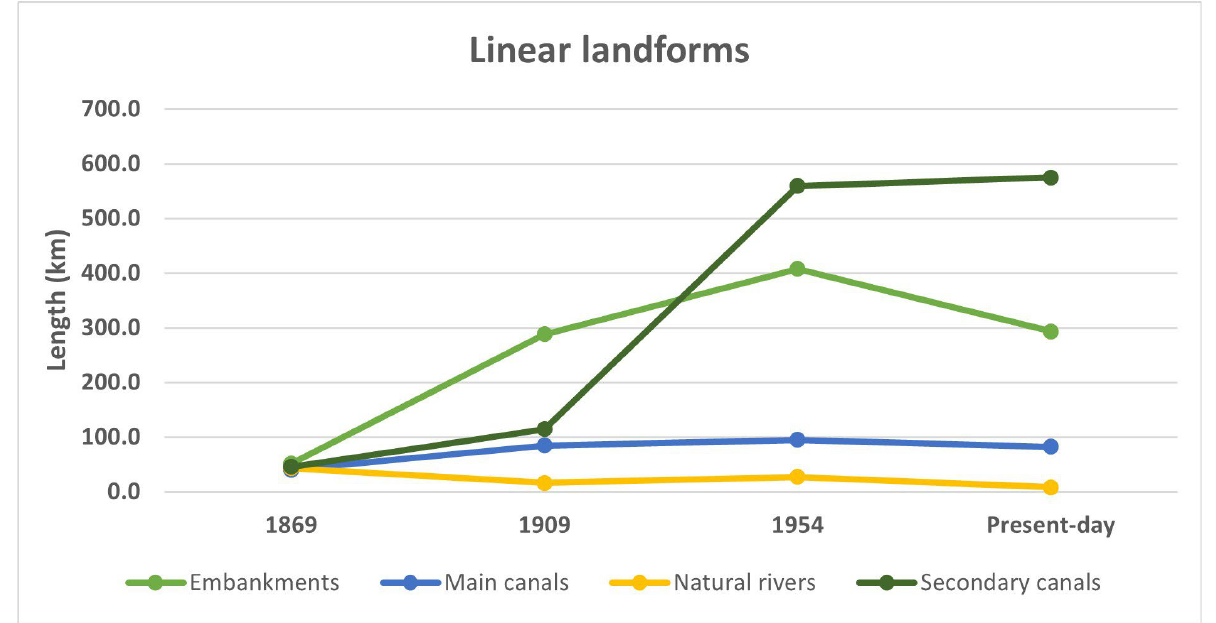
Figure 7. Evolutive trend of the linear landforms identified in the study area.